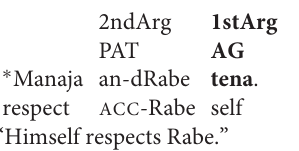
Algorithm before the First-Argument Algorithm 6 . Malagasy, a language with verb–object–subject order, is a case in